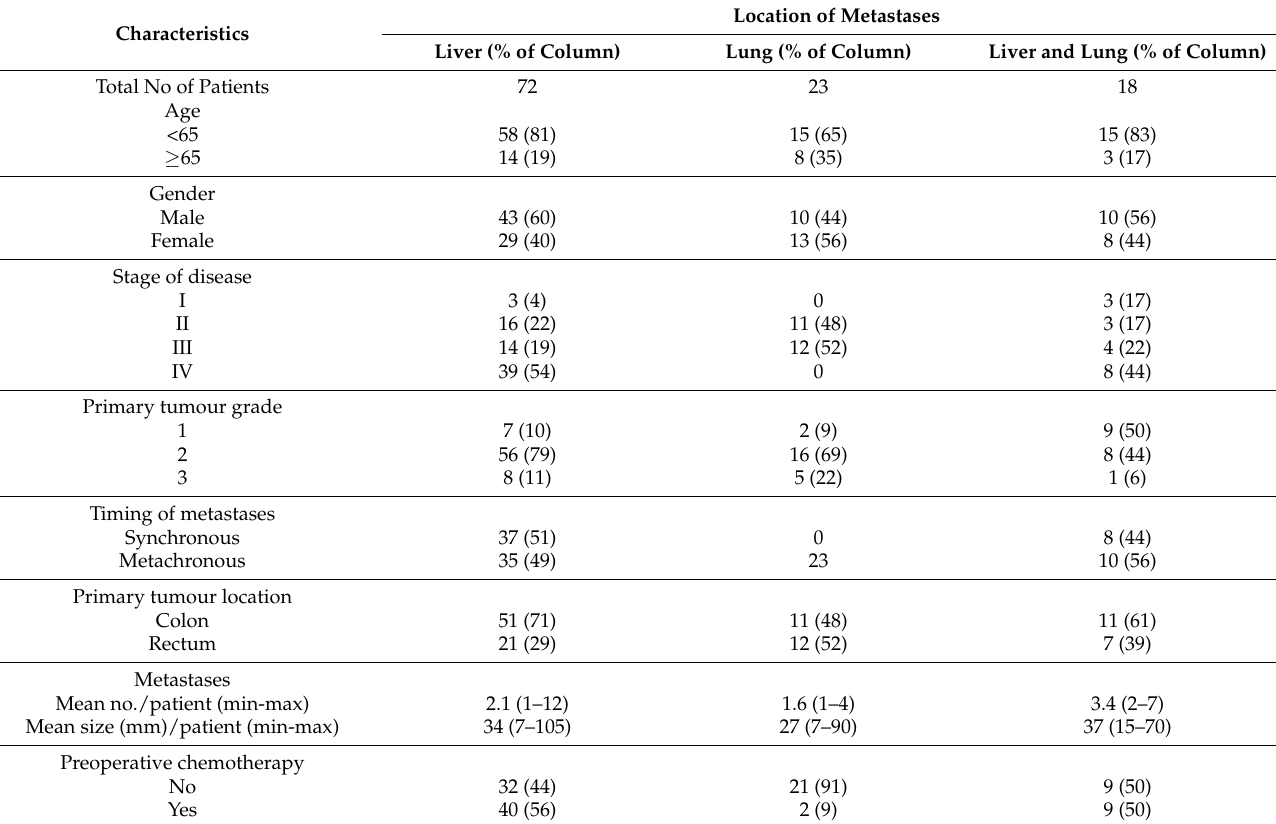
Table 1. Cinicopathological variables in patients with metastatic colorectal